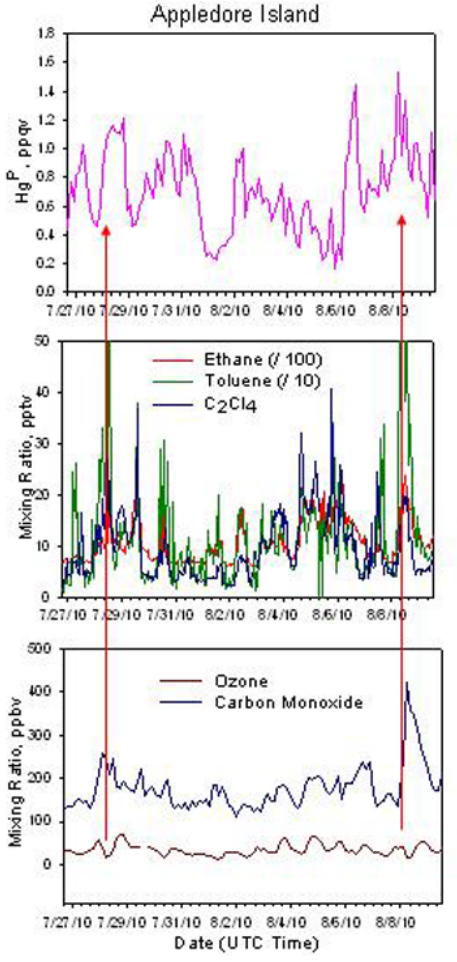
Fig. 10. Hydrocarbon data correlates with Hg P peaks shown for Ap- pledore Island. Top Panel: bulk filter data for Appledore Island dur- ing summer 2010. Middle Panel: hydrocarbon data from hourly can- ister samples showing ethane (purple), toluene (green), and tetra- chloroethylene (blue). Ethane values are graphed as a factor of 100 and toluene is a factor of 10, at one hour time resolution. Bottom Panel: ozone (red) and carbon monoxide (blue) data from Apple- dore Island at one hour time resolution. The same is shown for Ap- pledore Island, where peaks in different substances indicate eleva- tion in Hg P